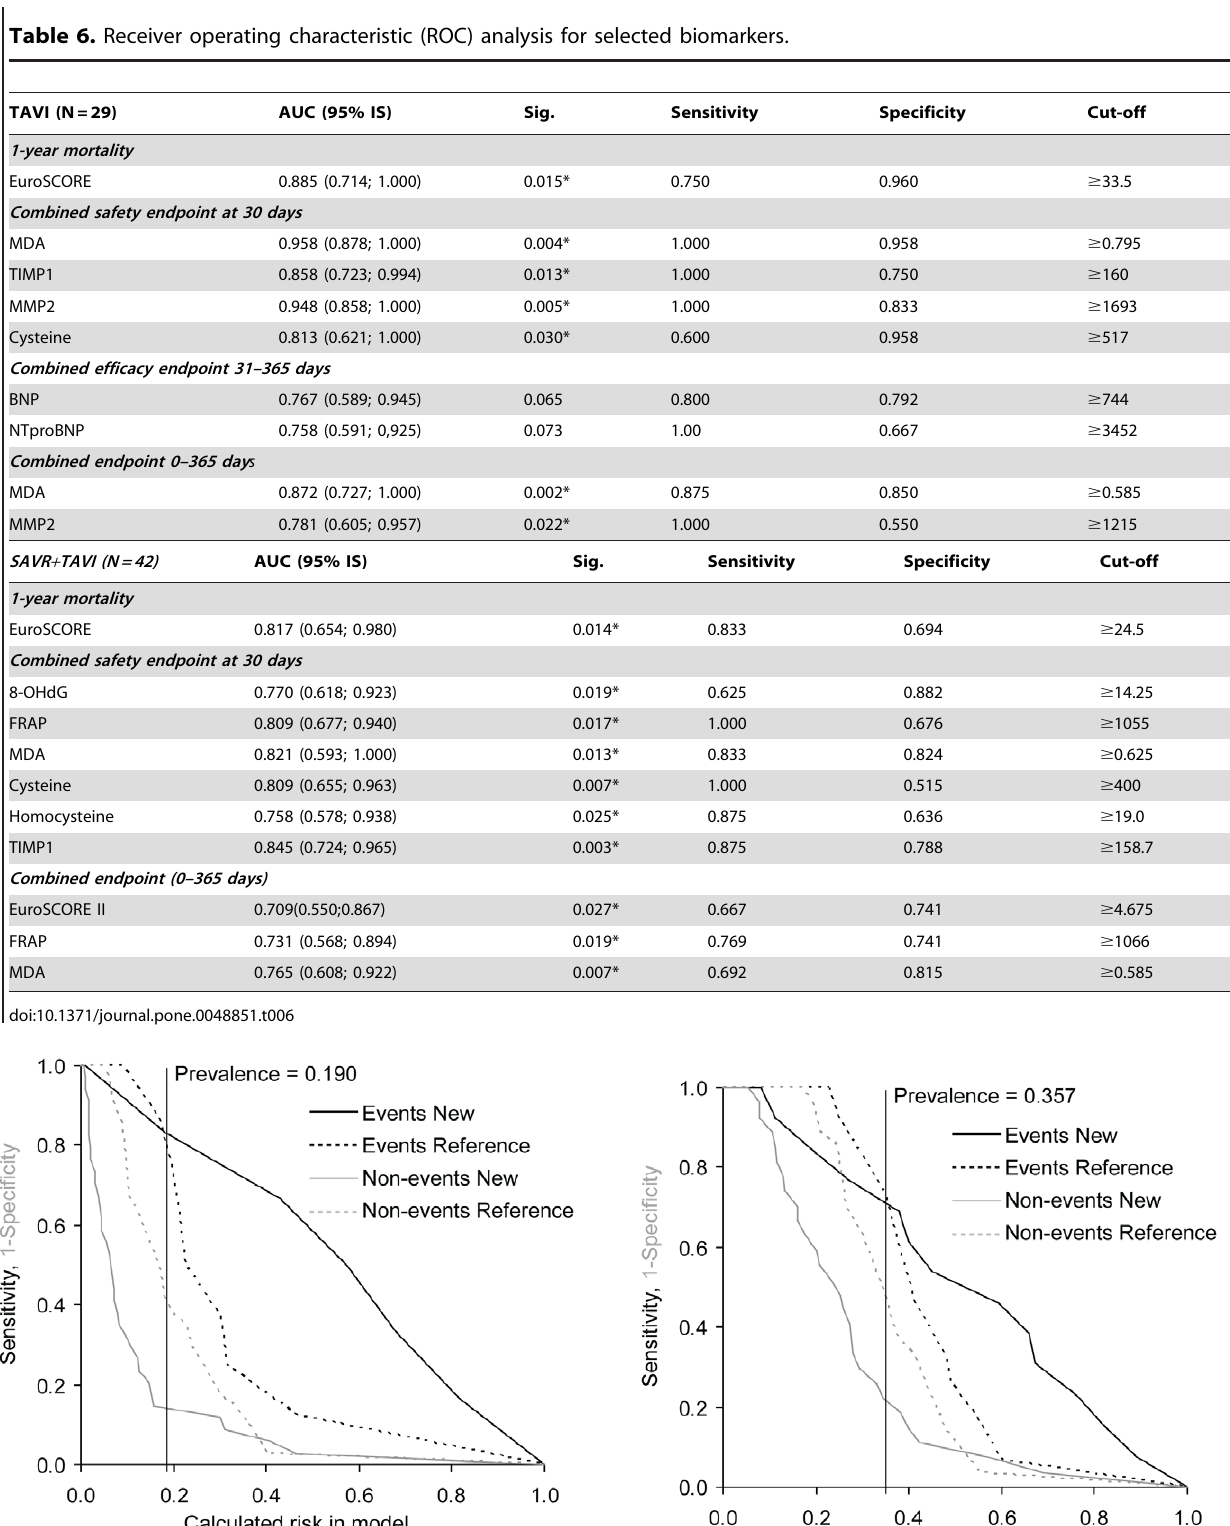
Table 6. Receiver operating characteristic (ROC) analysis for selected biomarkers.